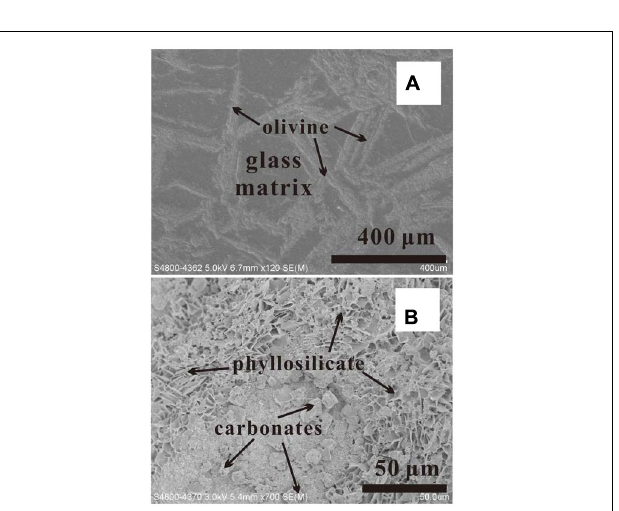
FIGURE 7 | SEM observations showing the surface of komatiite before (A) and after (B) experiment. The typical secondary minerals are phyllosilicate and carbonate (400 ◦